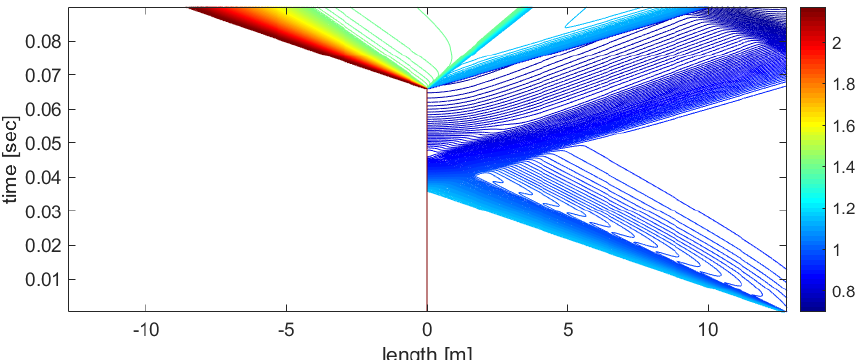
Figure 9. x − t diagram of the process, visualized using the density contour lines, for the HPC and LPP regions.